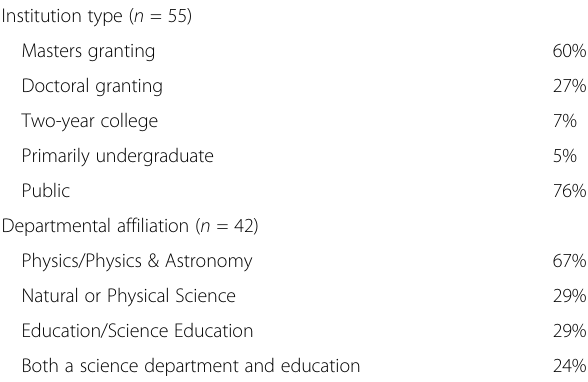
Table 2 Institutional context of faculty participating in the Next Gen PET